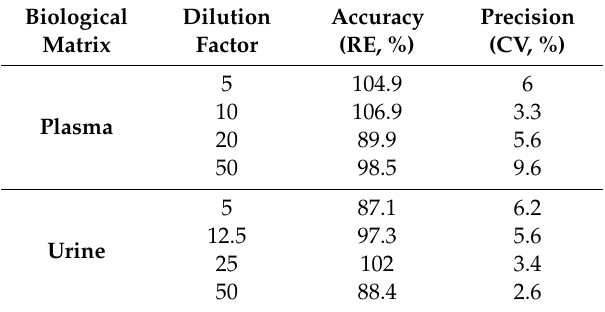
Table2. Dilutionintegrity. Accuracyandprecisiondemonstratetheeffectofdilutiononthequantification